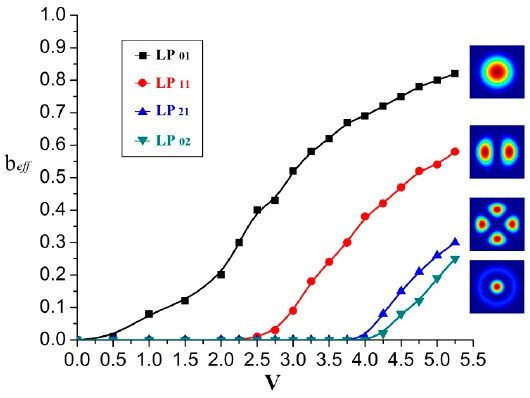
Figure 2. Normalized propagation constant b eff vs. V for LP modes under weakly coupling approximation.